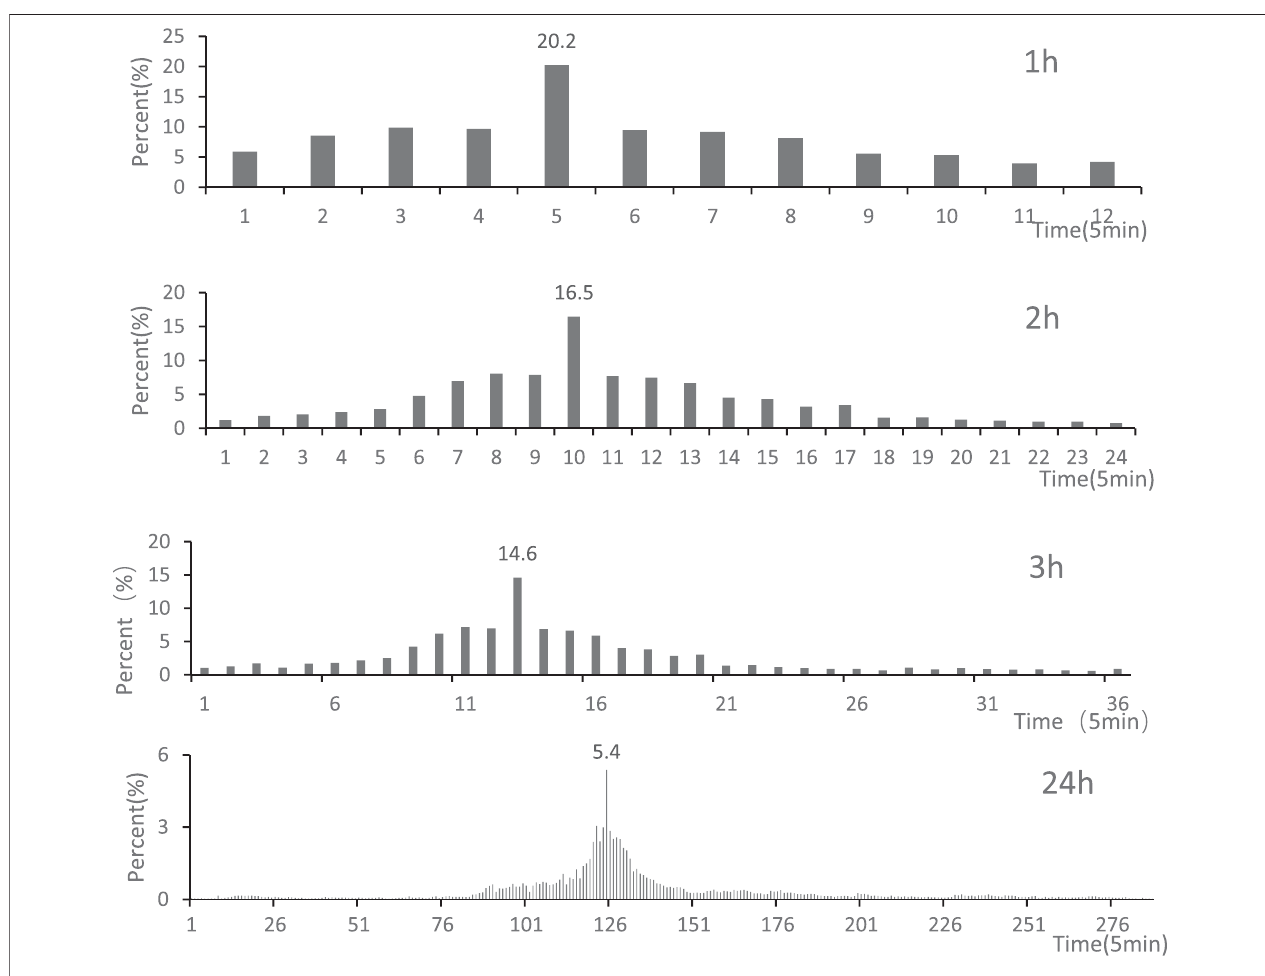
FIGURE 3 | The rainstorm hyetograph designs for four durations obtained with the Common-frequency method.